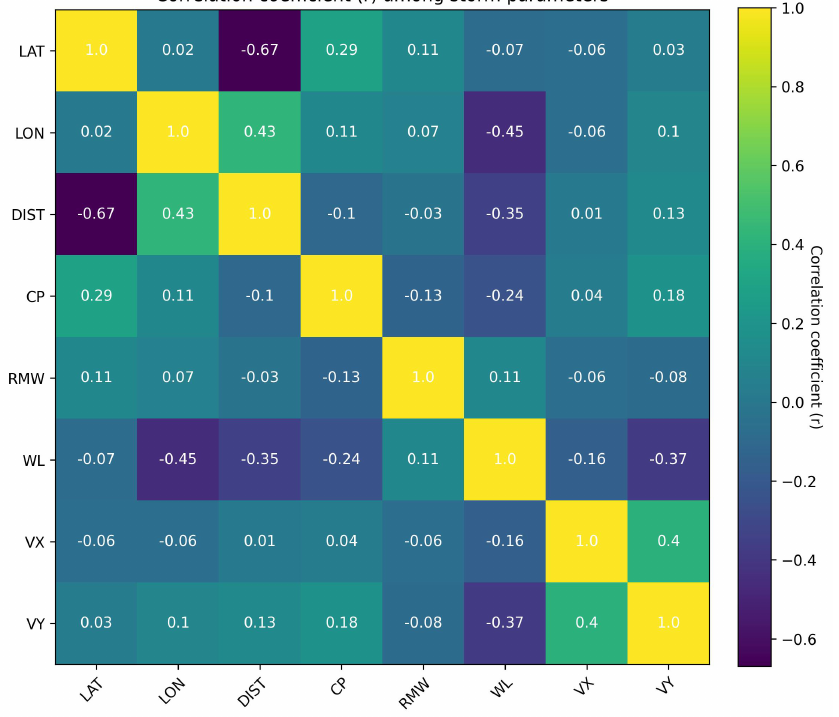
Figure 2. The Pearson standard correlation coefficient among storm parameters used to develop storm surge forecast model. LAT: latitude of storm center; LON: longitude of storm center; DIST: Distance between storm center and save point; CP: Central pressure of a storm; RMW: radius of the maximum winds; WL: storm surge water level; VX: storm − induced velocity in the x direction, and VY: storm − induced velocity in the y